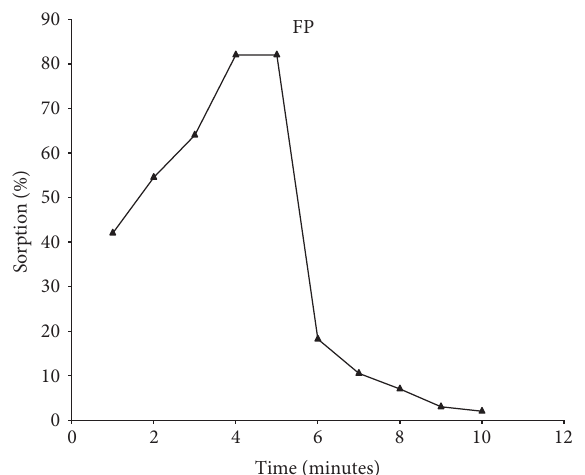
F 2: Variation of water sorption capacity of FP gum with time.